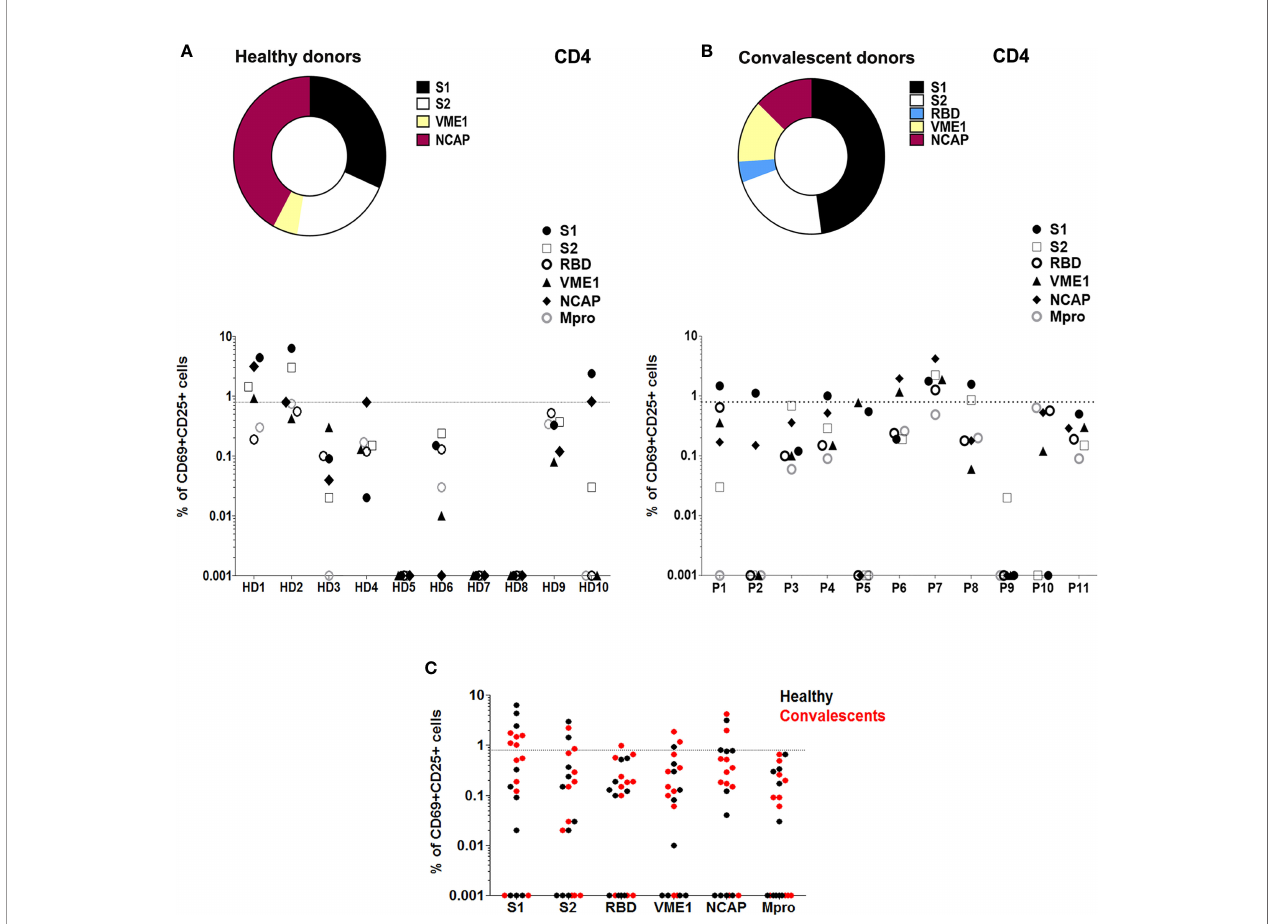
FIGURE 1 | T cell reactivity pro fi le to SARS-CoV-2 in healthy and convalescent individuals before vaccination. (A) Upper panel , proportion of HD (n=10) with SARS- Cov-2-reactive CD4+ T cells after stimulation with different peptide pools as indicated. Lower panel , T cell activity against different peptide pools measured in each HD. (B) Upper panel , proportion of CD (P; n=11) with SARS-Cov-2-reactive CD4+ T cells after stimulation with different peptide pools as indicated. Lower panel , T cell activity against different peptide pools measured in each CD. (C) T cell activation in HD (black) and CD (red), in the presence of speci fi c SARS-CoV-2 peptide pools. T cell activity was measured as speci fi c percentage, considered positive when ≥ 0.85% (dotted